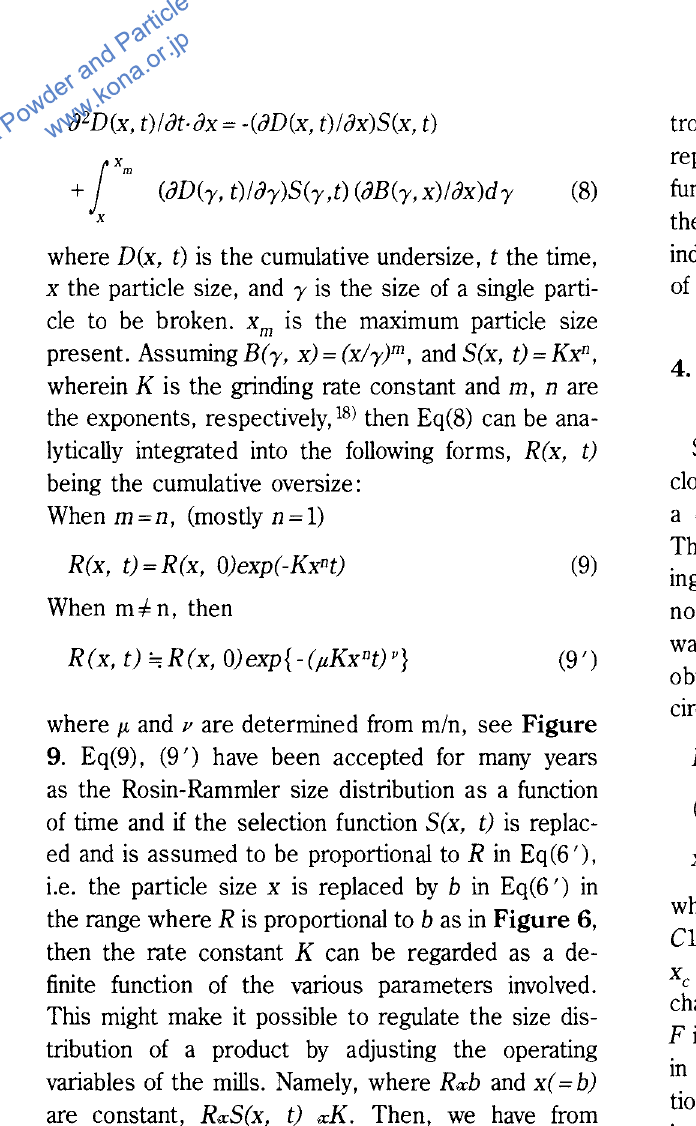
Fig. 10 Relationship between the selection function and the fractio nal powder filling in a ball mill, presented by Shoji et al